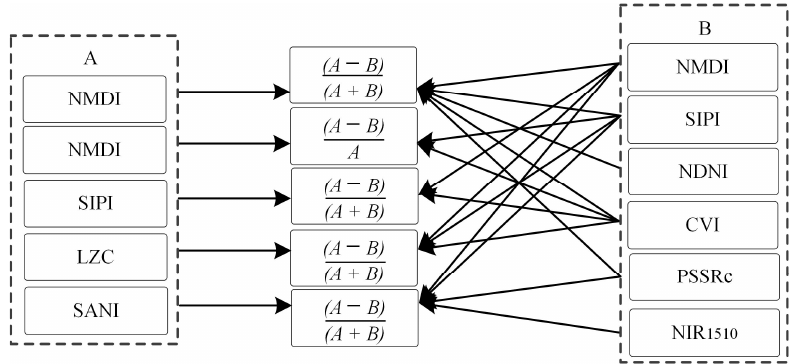
Figure 3. Combined indexes.